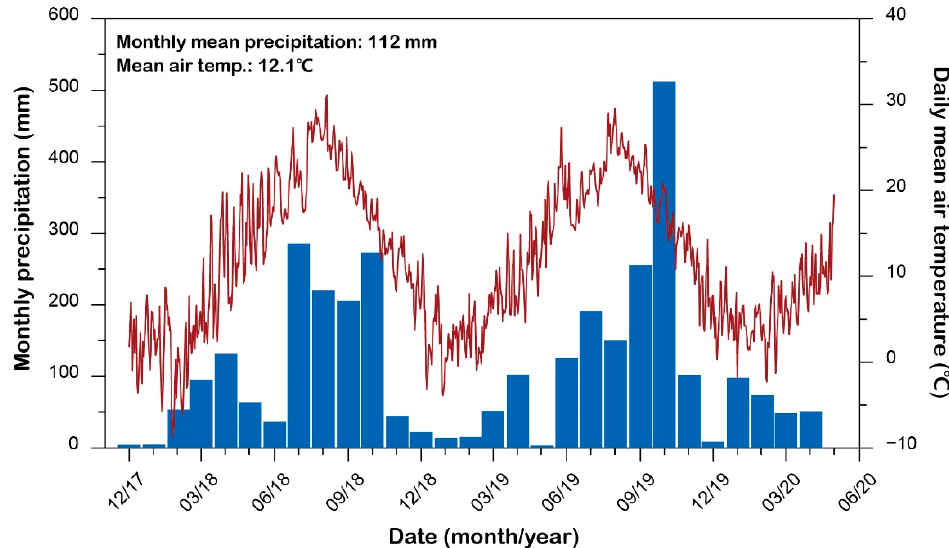
Figure 2. Monthly precipitation and daily mean air temperature measured at the automatic weather station, approximately 10 km northwest of the study area.